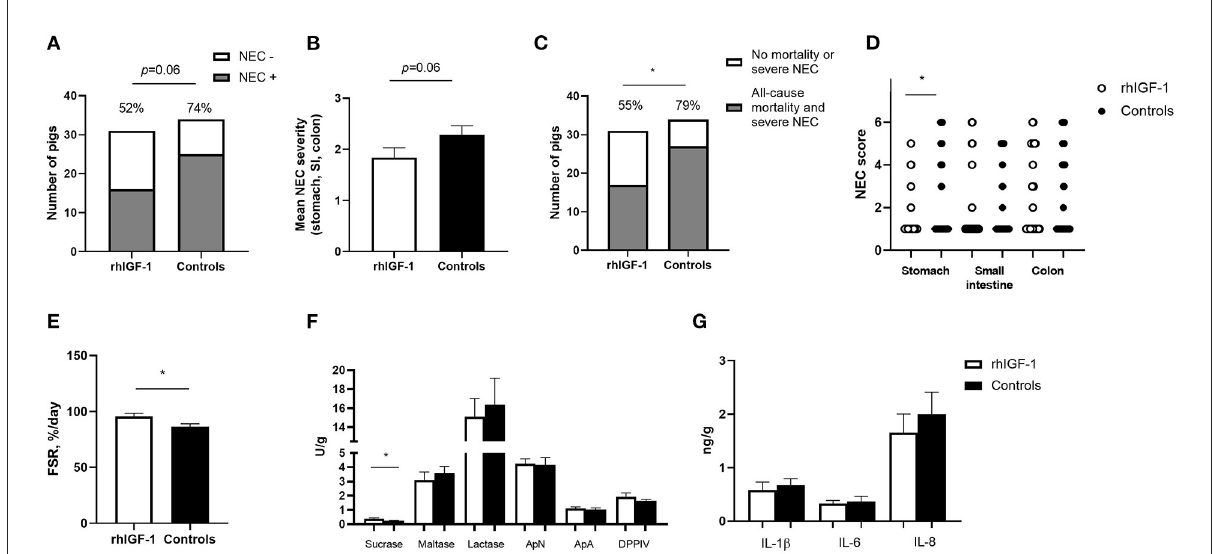
FIGURE4 Intestinal parameters in Experiment 1. (A) Incidence of NEC (score ≥ 3 in at least one gut region) day 2–9 in rhIGF-1 and control preterm pigs ( n = 31–34). (B) Average NEC severity score across gut regions in rhIGF-1 and control preterm pigs day 2–9 ( n = 31–34). (C) Incidence of all-cause mortality and severe NEC day 2–9 ( n = 31–34). (D) Individual NEC score distribution in stomach, small intestine (highest score of proximal, middle and distal section) and colon in rhIGF-1 and control preterm pigs day 2–9. (E) Fractional protein synthesis rate (FSR) in the distal small intestine of rhIGF-1 ( n = 19) and control ( n = 14) preterm pigs. (F) Brush border enzyme activities in proximal small intestine ( n = 23–24). (G) Pro-inflammatory cytokines in colon ( n = 22–24). rhIGF-1, recombinant human insulin-like growth factor-1; NEC, necrotizing enterocolitis; ApN, aminopeptidase N; ApA, aminopeptidase A; DPPIV, dipeptidylpeptidase; IL, interleukin. Values are mean ± SEM. * p <